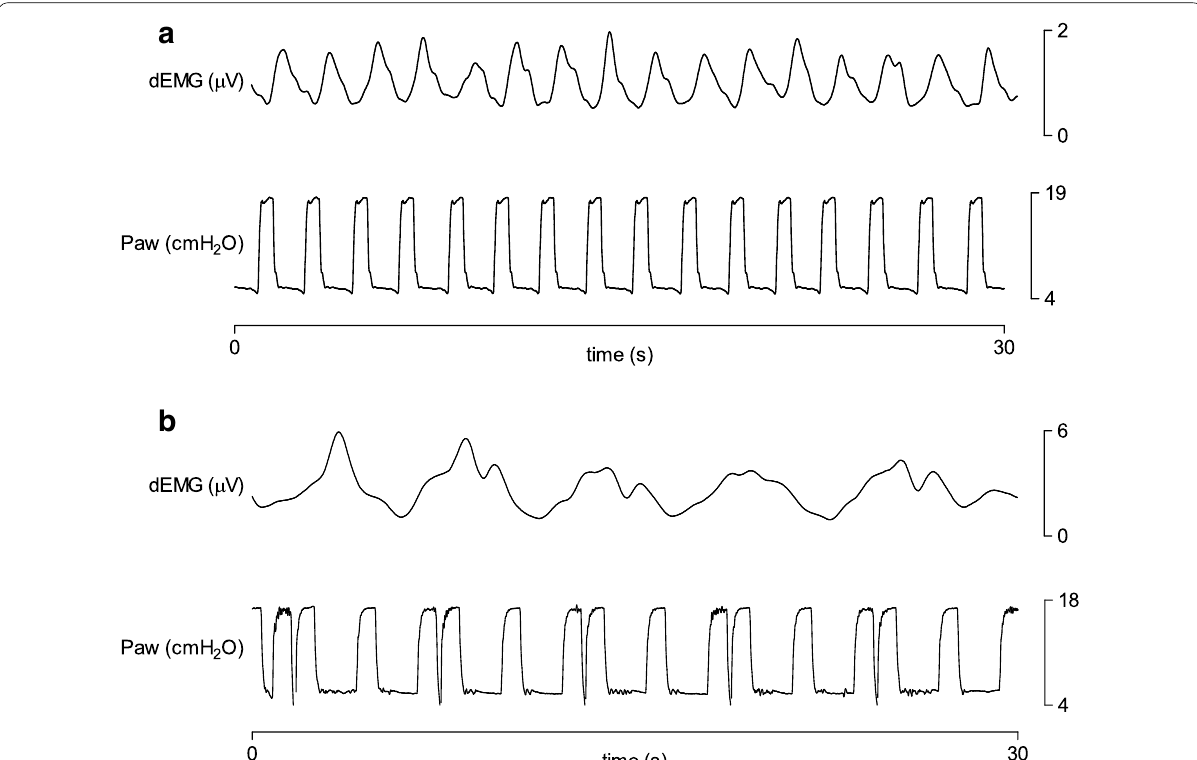
Fig. 3 Representative examples of transcutaneous diaphragm EMG and ventilator pressure–time tracings. Patient A is showing good patient– ventilator interaction. Patient B is showing poor patient–ventilator interaction with multiple ventilator pressurization within one period of neural